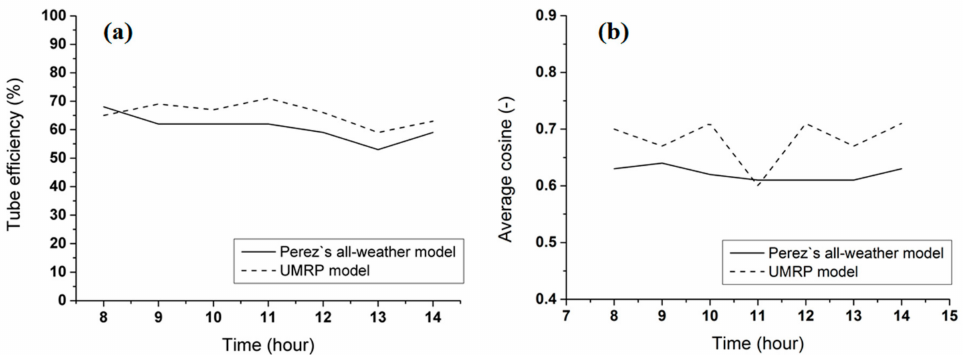
Figure 11. The same as in Figure 6, but for a partly cloudy day, 17 September 2015.